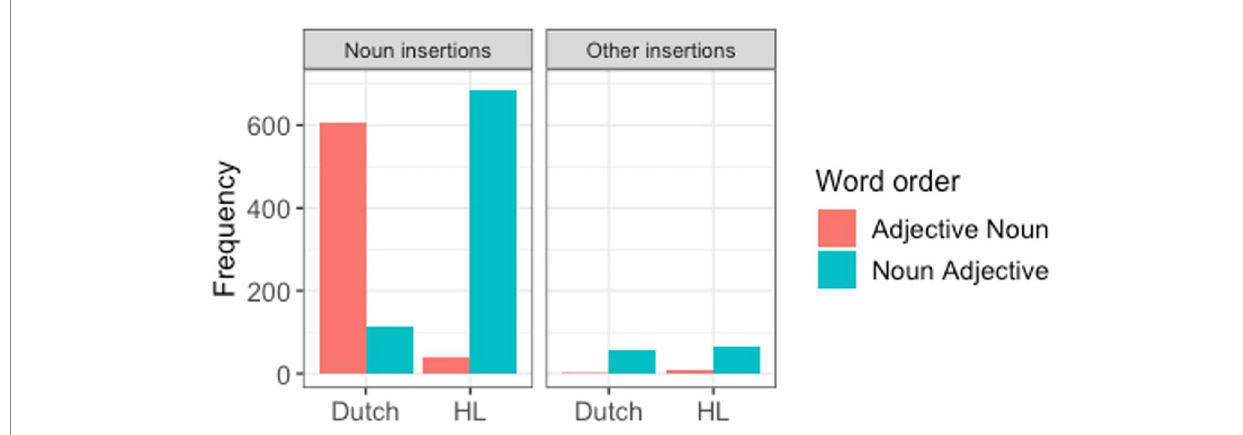
FIGURE 1 Production of word order in code-switching mode by ML and insertion type.